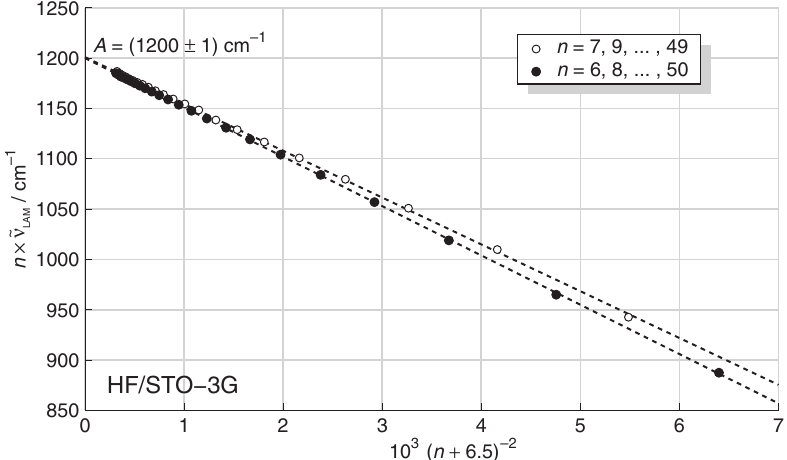
Figure 3. Extrapolation of deperturbed harmonic HF/STO-3G LAM-1 wavenumbers (Gaussian 03 [23]) to in fi nite chain length ( n